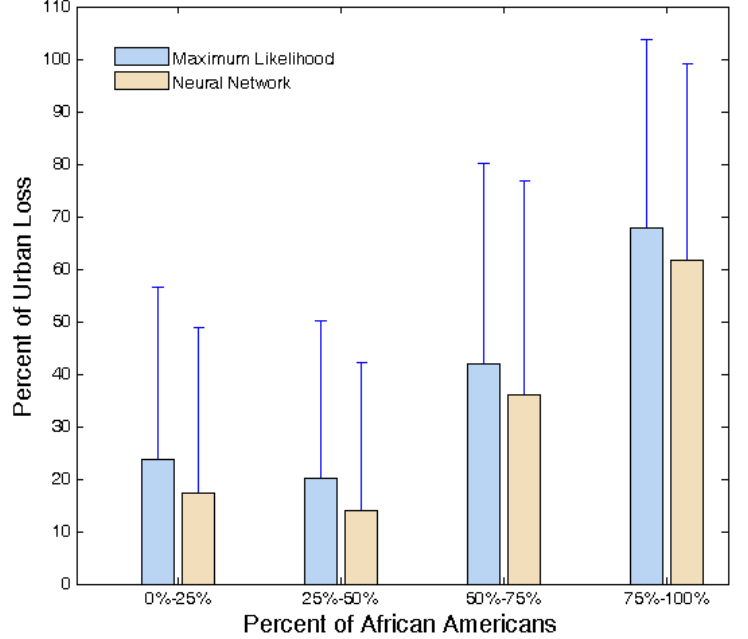
Figure 8. Relationship between percentage of African-American residents and urban loss.